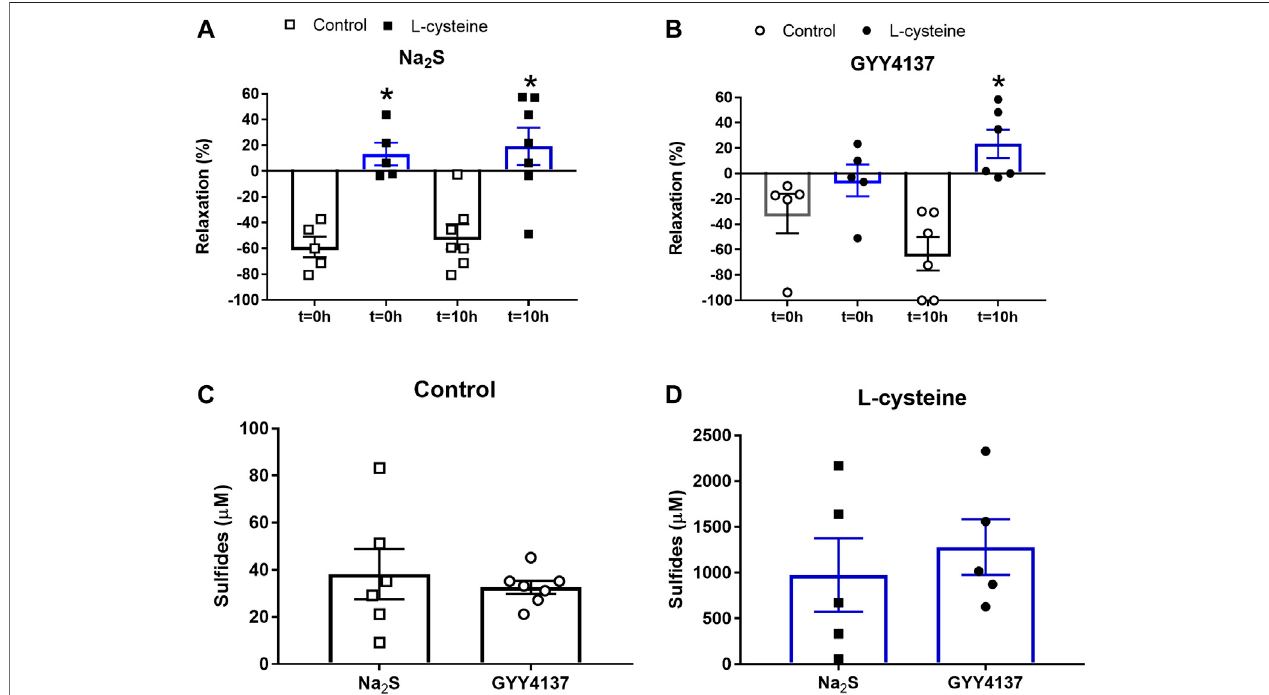
FIGURE2| Effect ofL-cysteine onNa 2 Sand GYY4137 relaxations inrat smallmesenteric arteries.Mixture ofNa 2 S(300 µM) orGYY4137 (1 mM)withand without L-cysteine (1 mM)wasadded to air-tight bottles and relaxations measured totime (cid:2) 0and 10 h for (A) Na 2 S and (B) GYY4137, and the amount of sul fi des measured at 10 h for (C) Na 2 S and GYY4137 in the absence, and for (D) Na 2 S and GYY4137 in the presence of L-cysteine, where the concentration of sul fi des generated by L-cysteine were subtracted. Please note the difference in scale comparing data in (C and D) . Data are means ± SEM ( n (cid:2) 6). * p < 0.05, Students t -test.